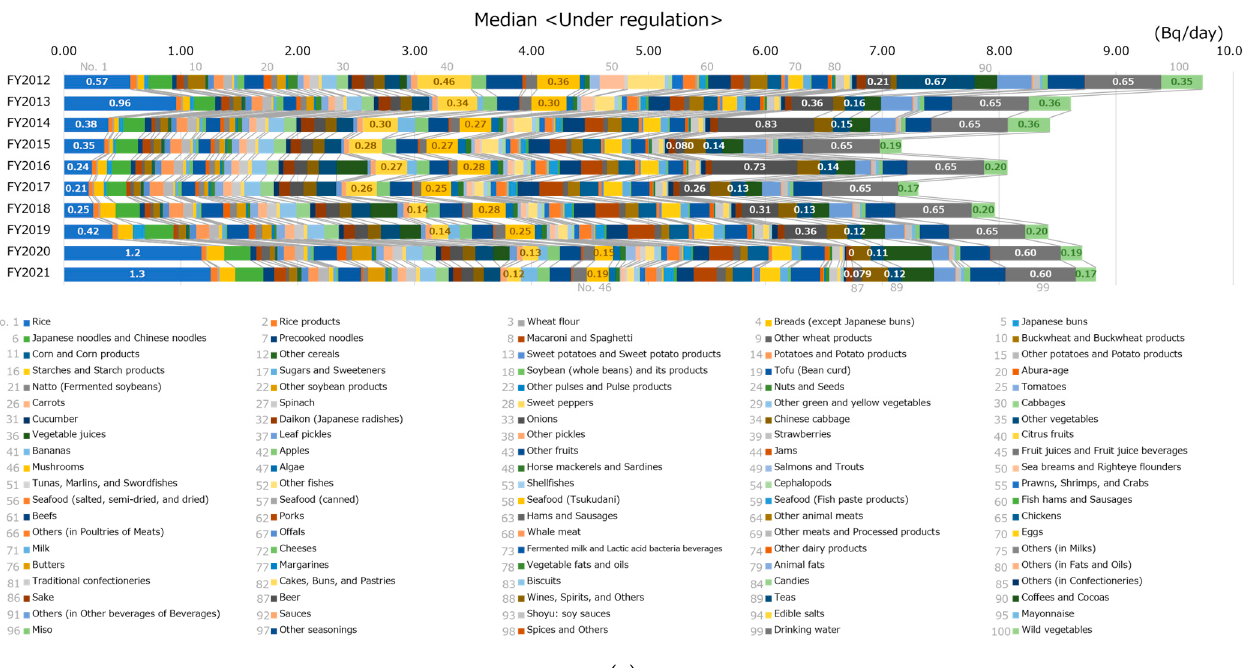
Figure 4. Breakdown of cesium ingestion per food classification: ( a ) median and ( b ) 95th percentile of cesium ingestion by 10,000 virtual persons. The percentile values of cesium ingestion in each food category were obtained, and the values for all food categories were summarized for each percentile. Hence, it does not necessarily mean that the same virtual person ingests them all. For food classifications with moderately high cesium ingestion, the values of cesium ingestion are also indicated in the figure. Specifically, values for rice, citrus fruits, mushrooms, beer, teas, drinking water, and wild vegetables are included.